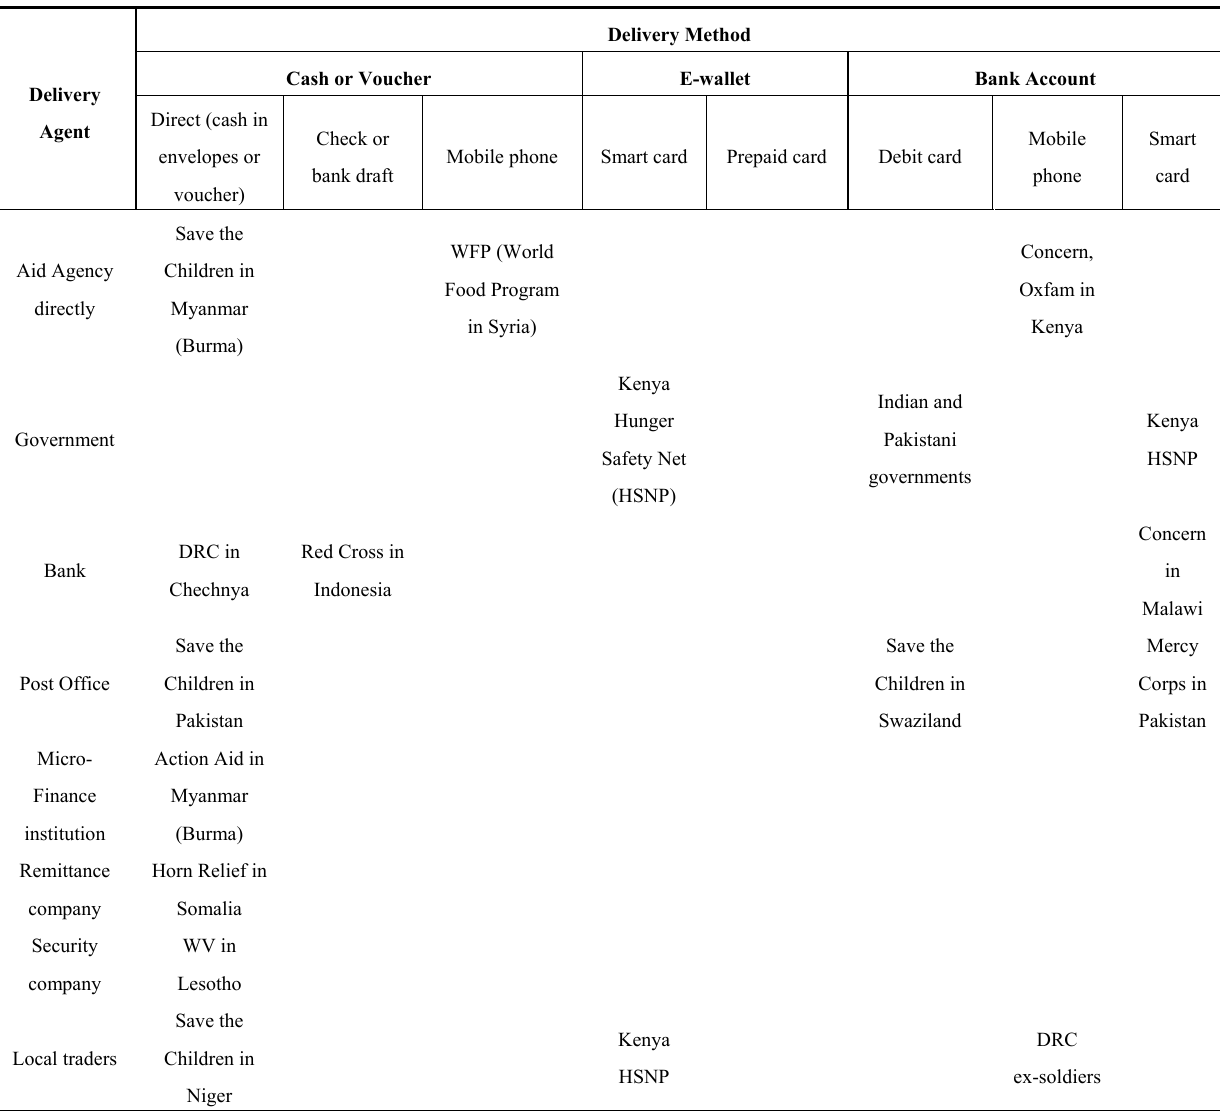
Table 1. Selected cash delivery